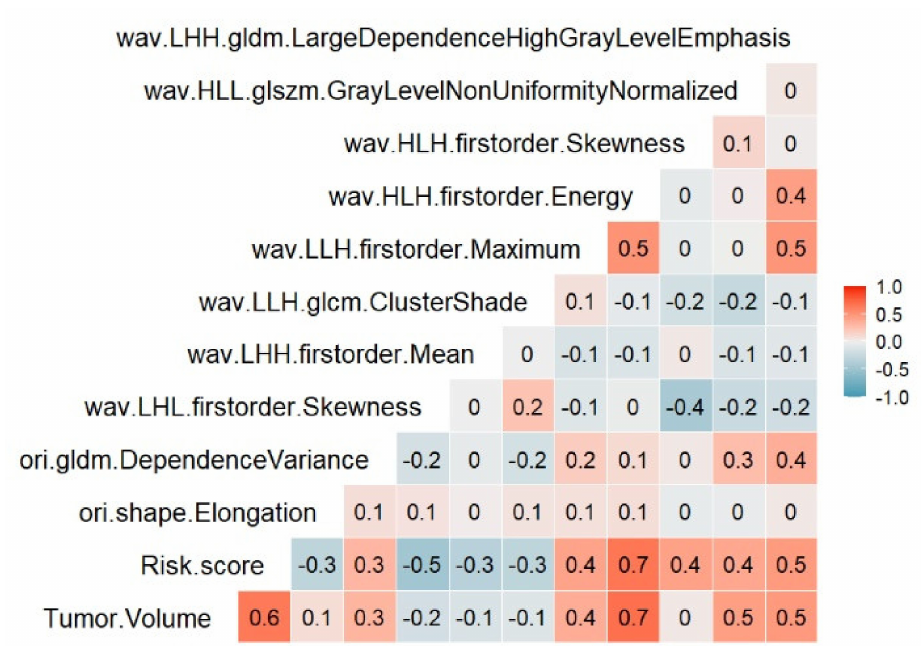
Figure 3. Correlation between ten radiomics signature features, Risk score, and tumor volume in the training set.